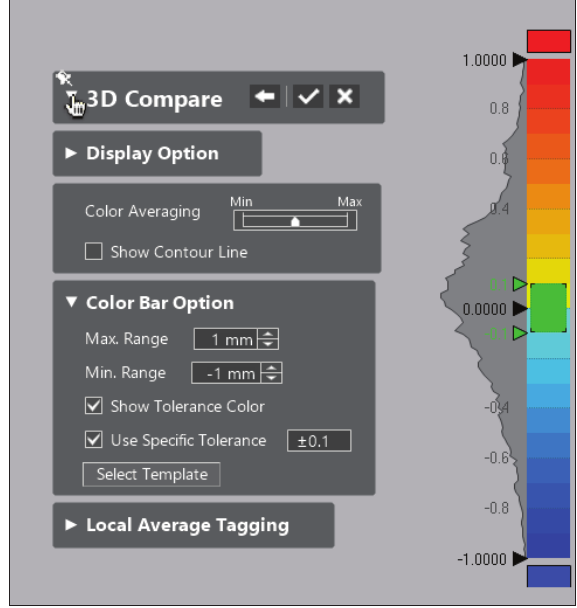
Figure 5. The heat map scale, showing controls that can be used to alter the scale. Current image is set to 1 mm deviation either side of ideal, with subdivisions at 0.1 mm.